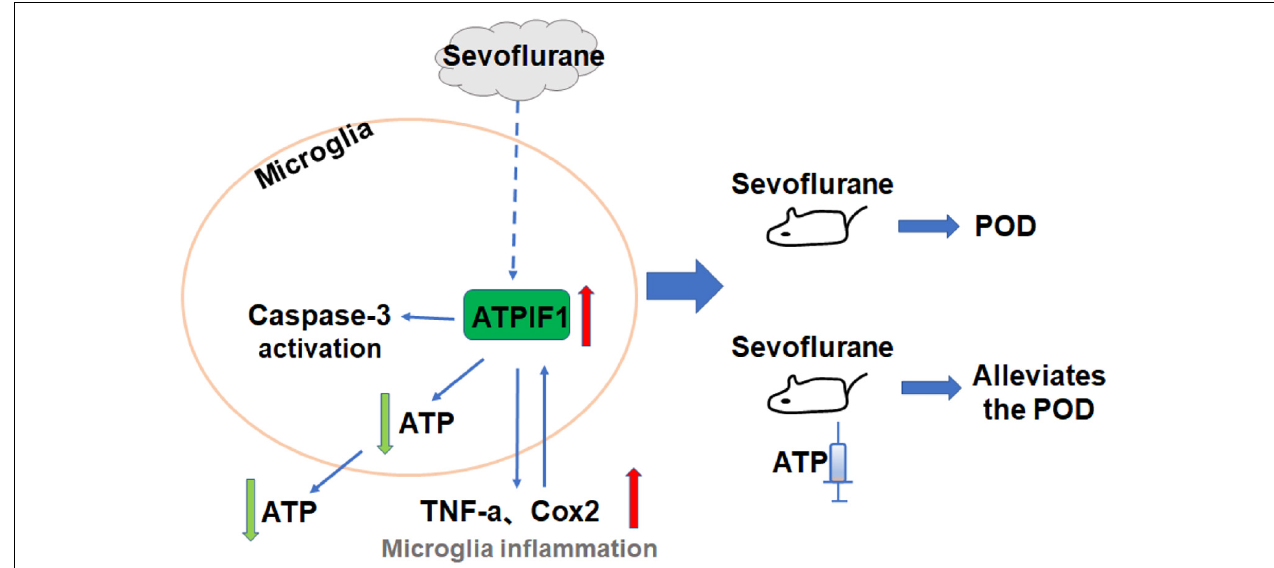
FIGURE 6 | The hypothesized pathway indicating sevoflurane regulates microglial inflammatory responses and caspase-3 activation. Proposed mode pathway indicates that the sevoflurane promotes ATPIF1 expression in microglia to induce inflammatory factor upregulation and capsase-3 activation and decrease ATP level. Supplementation of ATP alleviated sevoflurane induced anxiety behavior and memory damage in POD